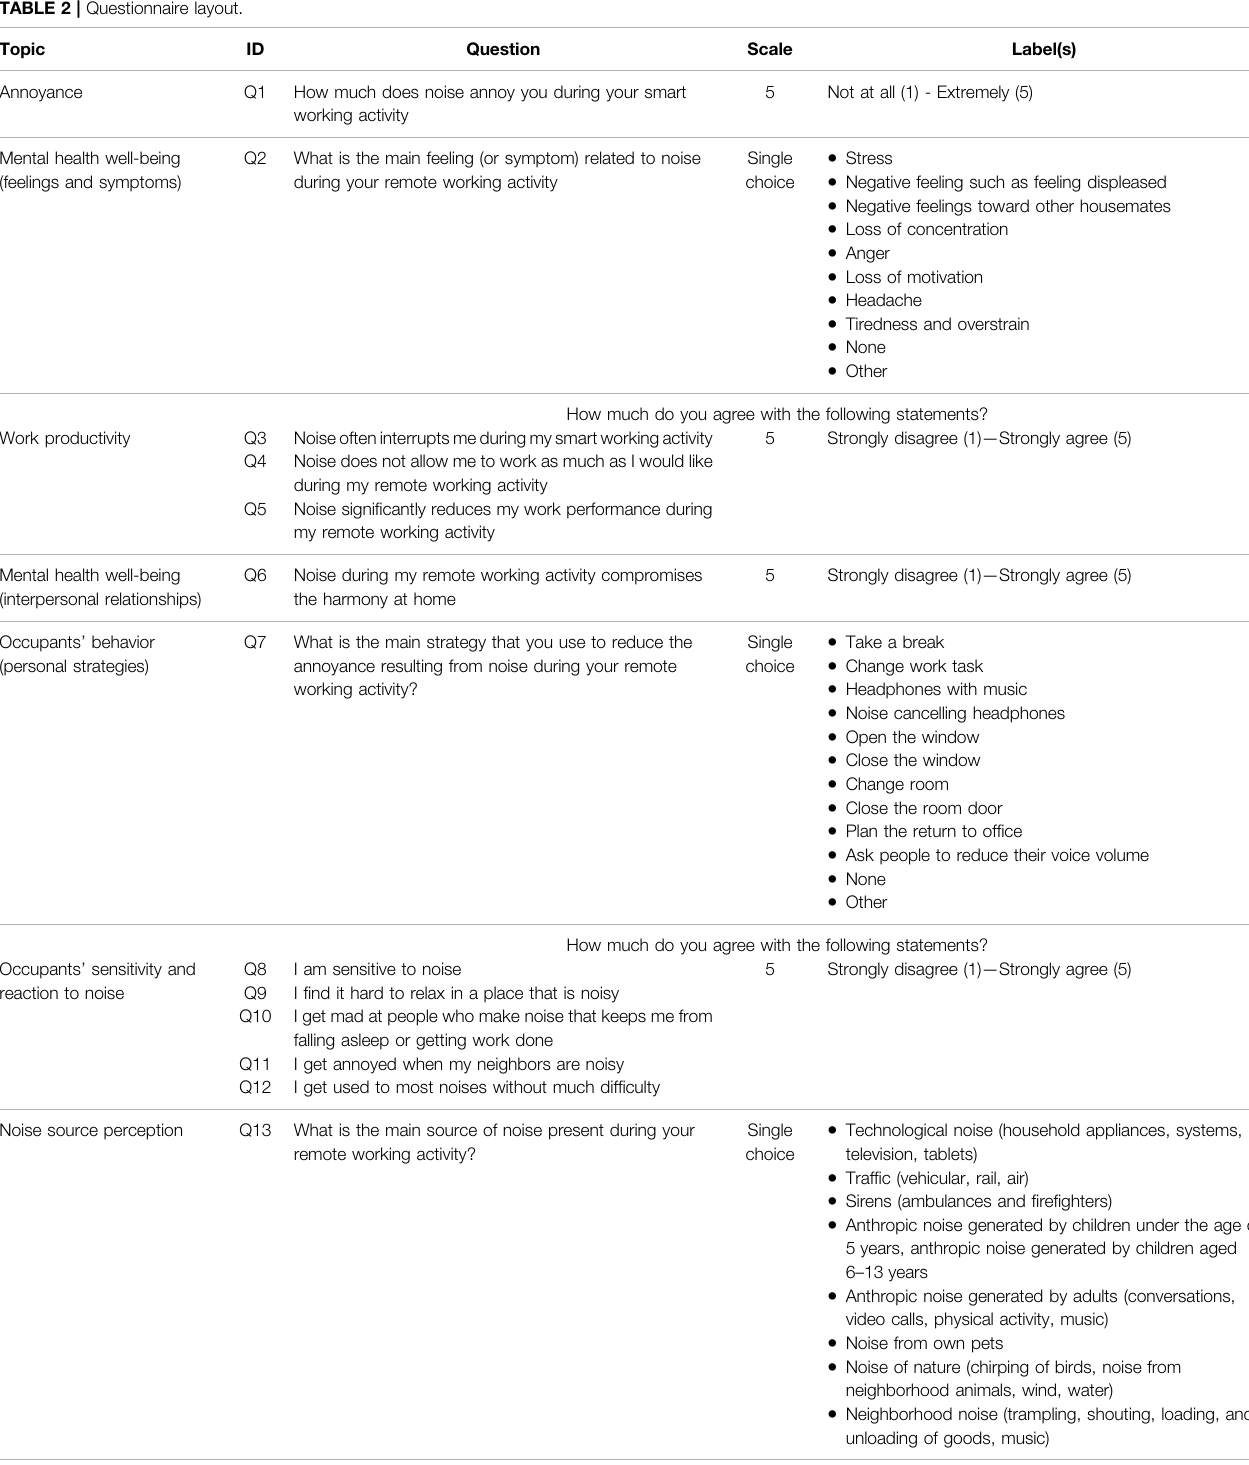
TABLE 2 | Questionnaire layout.